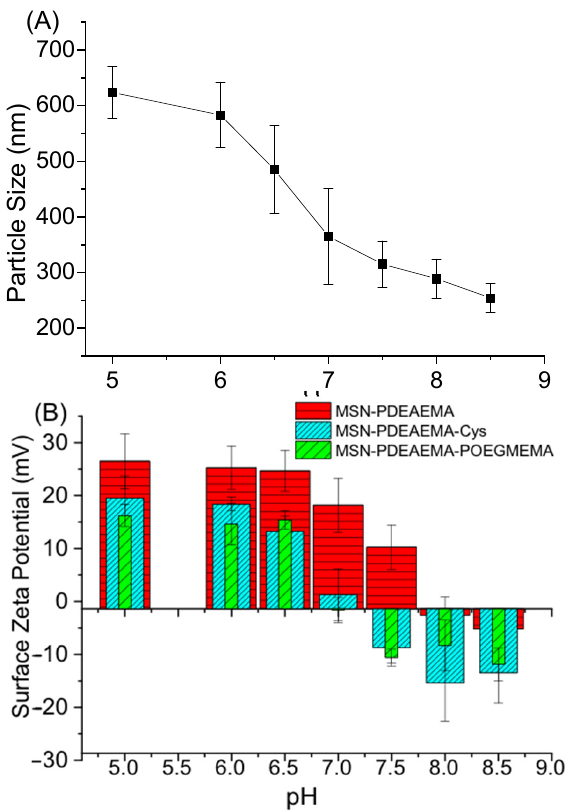
Figure 5. ( A ) The average particle size of MSN–PDEAEMA at different pH levels at 25 °C. (B) The surface zeta potential MSN-PDEAEMA, MSN-PDEAEMA-Cys, and MSN-PDEAEMA-Cys-POEGMEMA at different pH levels at 25 °C.